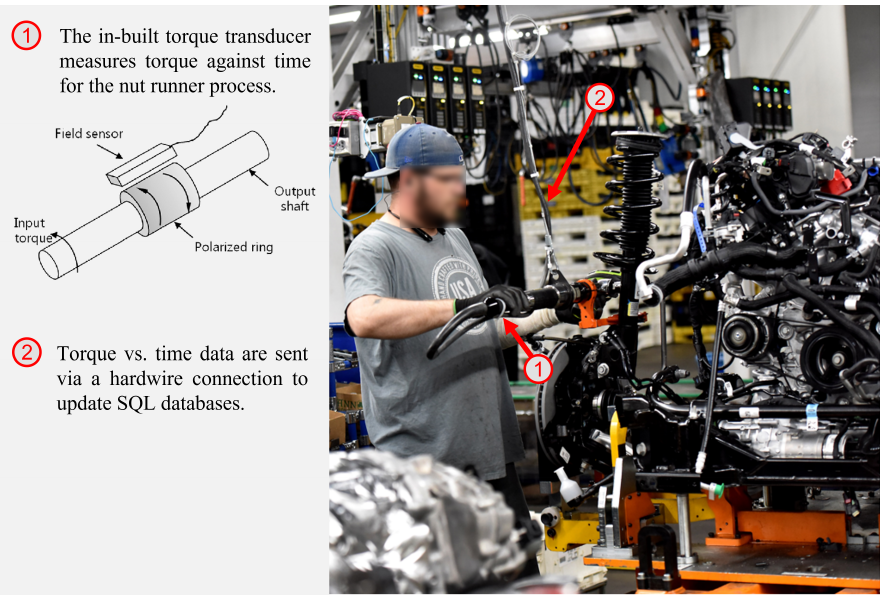
Figure 1. An example of a line worker using a DC nut runner tool in engine